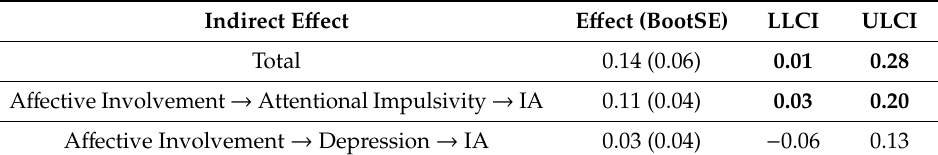
Table 4. Indirect e ff ects of a ff ective involvement on internet addiction through attentional impulsivity Table 3. Indirect effects of affective involvement on internet addiction through attentional and impulsivity and depression.